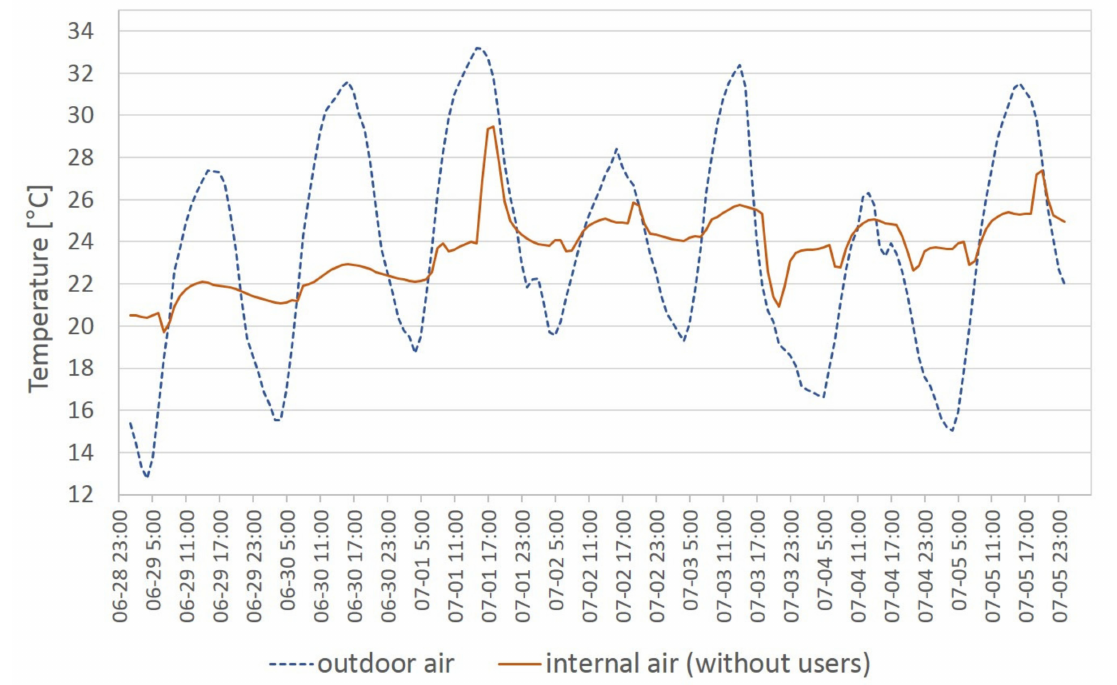
Figure 10. Distribution of indoor and outdoor air temperature during the selected week (without taking into account heat gains from people).